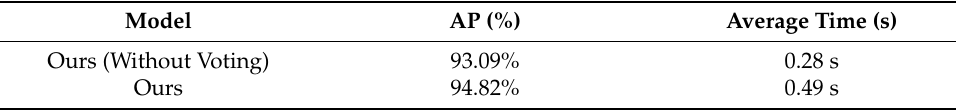
Table 8. Performance of models with different module on Dataset Table 9. Performance of models with different module on Dataset III.